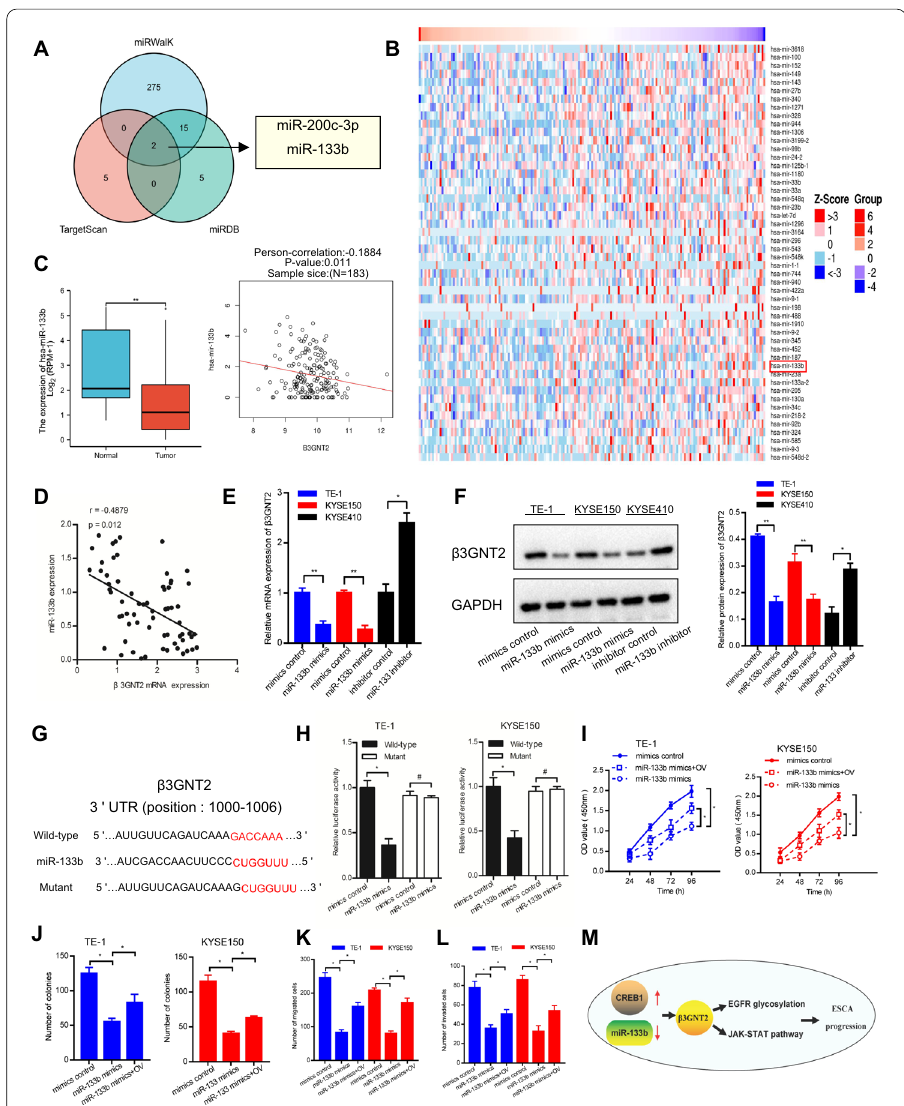
Fig. 8 β3GNT2 expression is controlled by miR-133b. A Prediction of regulatory miRNAs of β3GNT2. B Heatmap showing the top 50 miRNAs negatively correlated with β3GNT2 in ESCA. C Analysis of the correlation between miR-133b and β3GNT2 expression based on the TCGA database. D Correlation analysis of miR-133b and β3GNT2 expression in clinical ESCA samples. E Analysis of β3GNT2 mRNA expression by qPCR. F Analysis of β3GNT2 protein expression by Western blot. G Putative miR-133b binding site in the β3GNT2 3 ′ -UTR. H Dual-luciferase reporter activity assay. I – L The proliferation, colony formation, migration, and invasion of cells co-transfected with β3GNT2 overexpression plasmid and miR-133b mimics were measured by CCK-8 assay ( I ), colony formation assay ( J ), Transwell migration assay ( K ), and Matrigel invasion assay ( L ). M Diagram of the proposed mechanism showing how β3GNT2 regulates ESCA progression. OV, cells transfected with pcDNA3.1/β3GNT2 plasmid. Data are expressed as mean SD. # P > 0.05, *P < 0.05; **P < ±